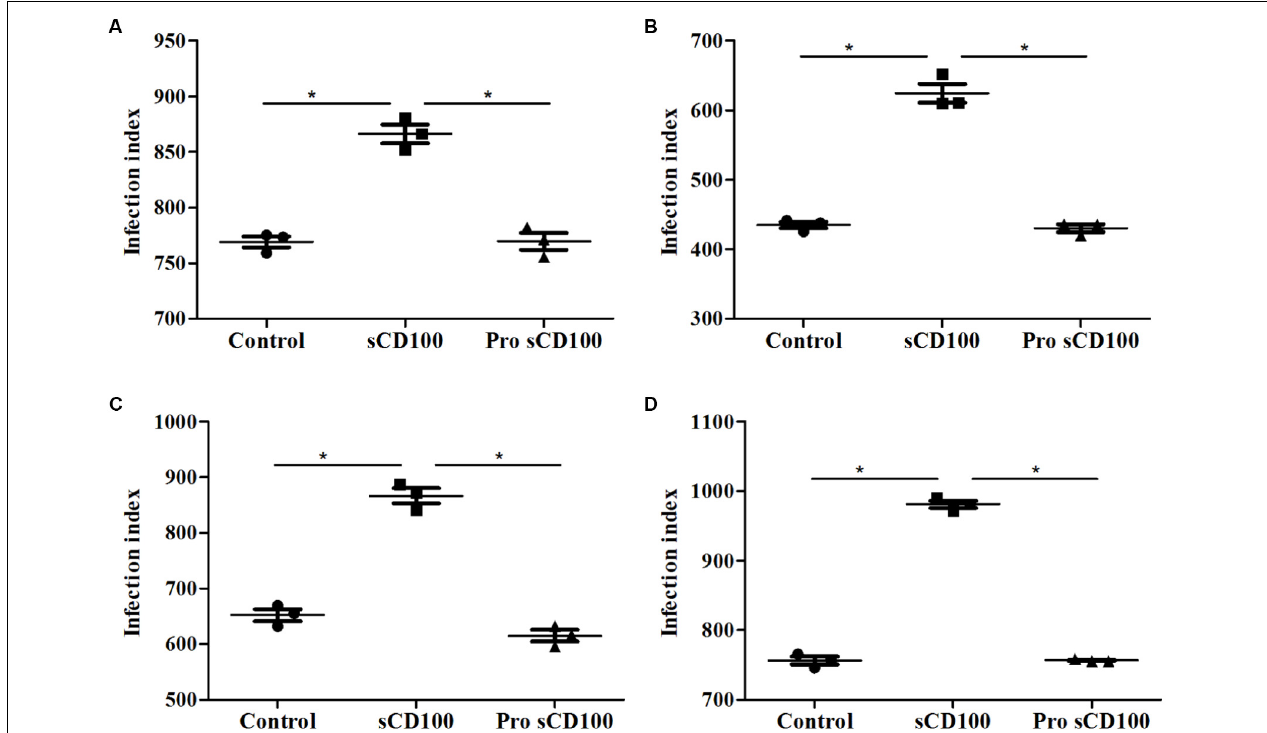
FIGURE 3 | Effects of preincubation of promastigotes with sCD100 on infection index. Peritoneal macrophages from BALB/c mice were infected with L. (L.) amazonensis at a MOI of 5 for 4 (A) , 24 (B) , 48 (C) , or 72 (D) hours at different conditions: macrophages and parasites without sCD100 (control), promastigotes preincubated with sCD100 at a concentration of 200 ng/mL (promastigote+sCD100), macrophages and promastigotes in the continuous presence of sCD100 at a concentration of 200 ng/mL (sCD100). Statistical analysis was performed by ANOVA with Tukey’s post-test, and significant differences are labeled as ∗ p ≤ 0.05. Results of a representative experiment of